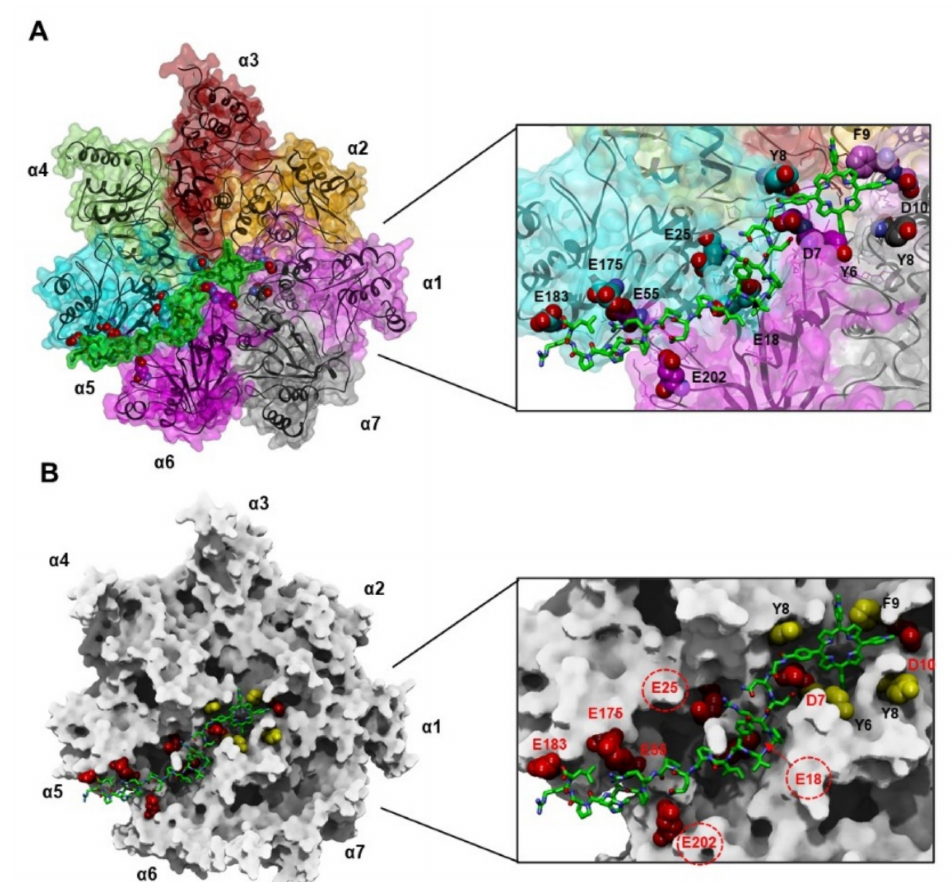
Figure 7. Selected docked complex of MTPyApi bound to h20S (closed conformation). ( A , B ): top and close-up view of the ligand binding site. The negative residues interacting with MTPyApi and those in common with H 2 T4 (porphyrin moiety) are displayed in CPK. ( A ) h20S backbone is displayed as black solid ribbons, while the transparent solvent accessible surface (SAS) and the displayed residues are colored in pink ( α 1), orange ( α 2), brown ( α 3), light green ( α 4), cyan ( α 5), magenta ( α 6), and gray ( α 7). MTPyApi is colored by atom type (C: black; N: blue; O: red), and its SAS is displayed (green). ( B ) h20S SAS is displayed as solid and colored in white. MTPyApi is colored by atom type (C: green; N: blue; O: red) and displayed in stick. The h20S interacting residues are colored: negatively charged = red, aromatic = yellow. The glutamate residues involved in ionic interactions with RPs are evidenced with a red dashed